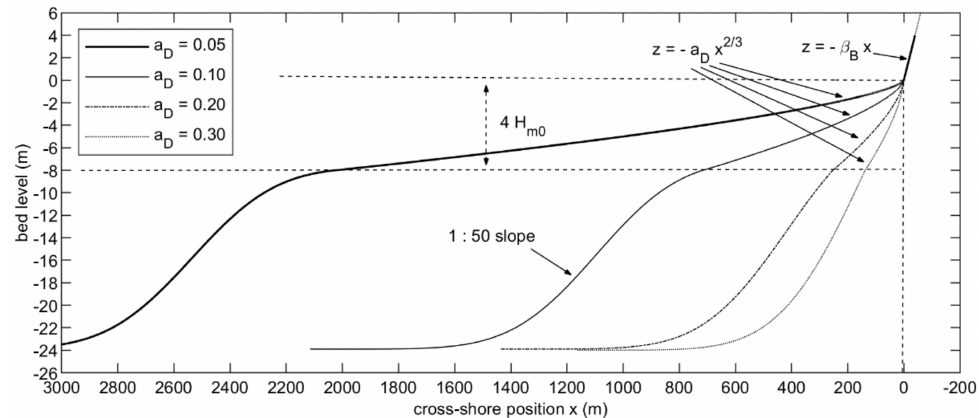
Figure 1. Cross − shore profiles for H m 0 = 2 m, T p = 12 s, tan β b = 0.10, and four values of a D (0.05, 0.10, 0.20, and